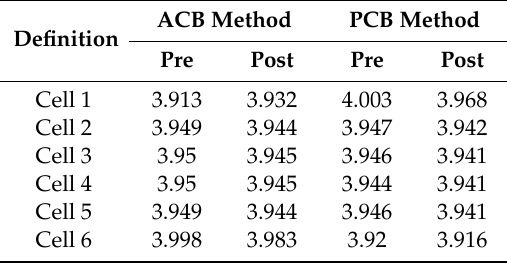
Table 11. Battery cells voltage variation under the ACB method and the PCB method.